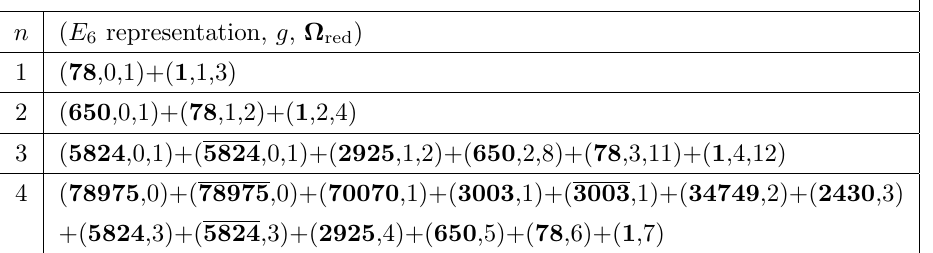
Table 2 . The allowed representations for BPS states with asymptotic charges n (3 ; 2), with 1 (cid:20) n (cid:20) 4, are listed. We also list the genus of the corresponding holomorphic curves, and the